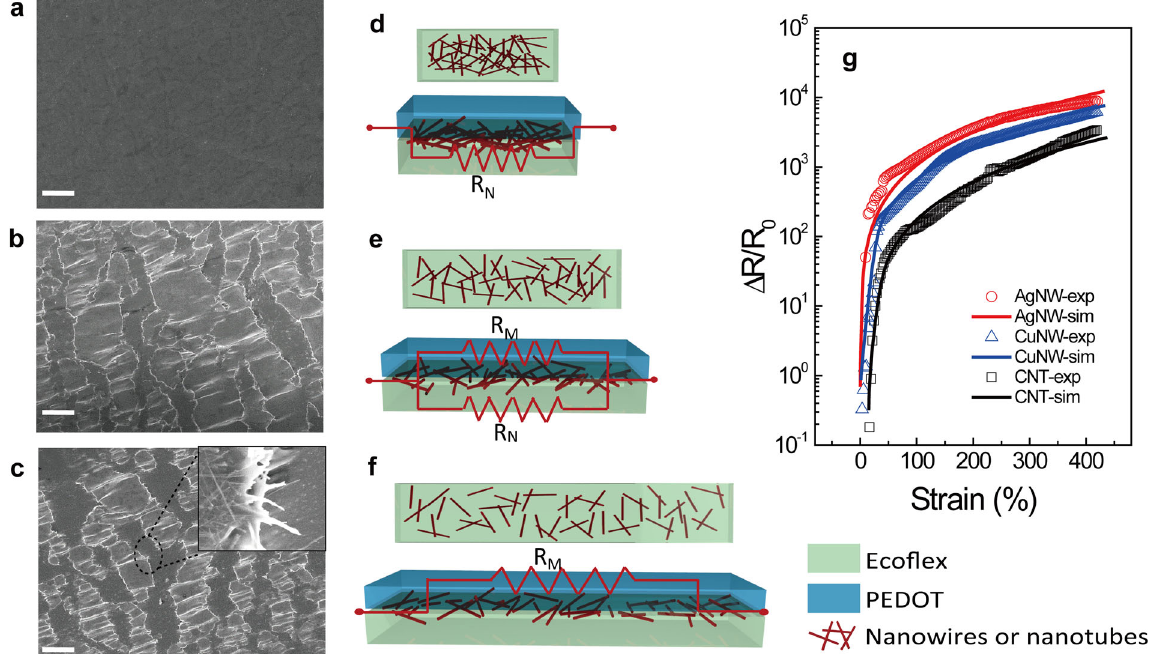
Fig. 4 SEM images of the CuNW/Eco fl ex composite under different strains: a 0%, b 15%, and c 80% (the inset is the magni fi ed crack). The scale bar is 60 μ m. c , f Corresponding schematic diagrams of stretched nanowire or nanotube networks (upper) and stretched devices (lower), showing the resistance networks. These schemes illustrate the conducting mechanisms of the NMH strain sensors corresponding to the evolution of the morphology on the left. g Relative change in the resistance of the NMH strain sensor obtained from experiments (open dots) and simulations using the proposed percolation model